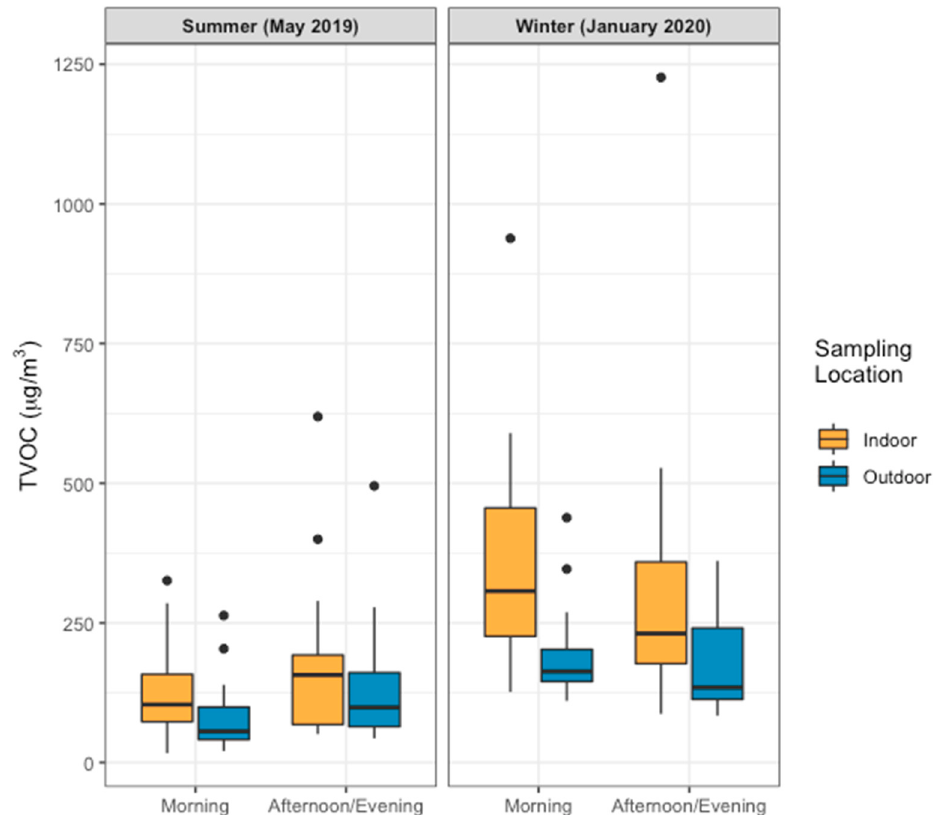
Figure 2. Concentrations of total volatile organic compounds indoors and outdoors during morning and afternoon/evening sampling for homes in Gandhinagar and Ahmedabad, India ( n = 20 in summer, n = 19 in winter). Boxes illustrate the 25th percentile, the median, and the 75th percentile, and the upper and lower whiskers extend from these percentiles to the largest and smallest values equal to or less than 1.5 times the interquartile range; dots indicate values lying outside of this range.